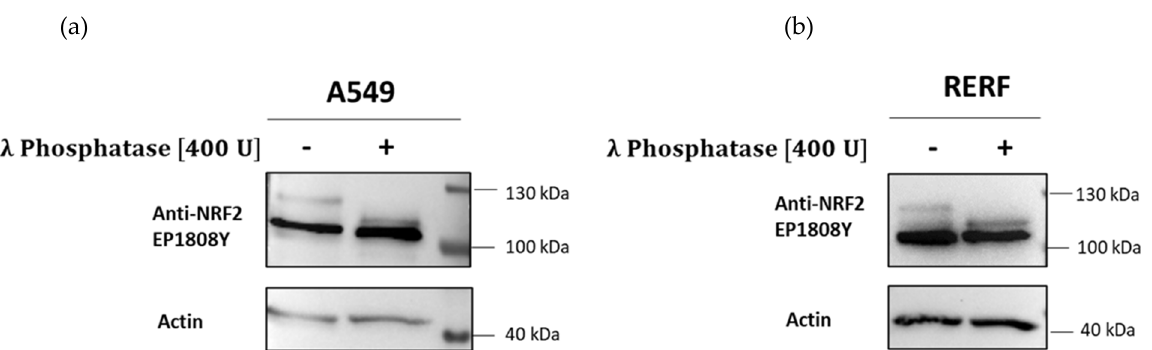
Figure 7. Lambda protein phosphatase ( λ PP) treatment of A549 ( a ) and RERF ( b ) lysates. Cell lysates were incubated with or without λ phosphatase for 30 min in 30 ◦ C in the presence of MnCl 2 and Nrf2 was detected by Western blot with Abcam EP1808Y